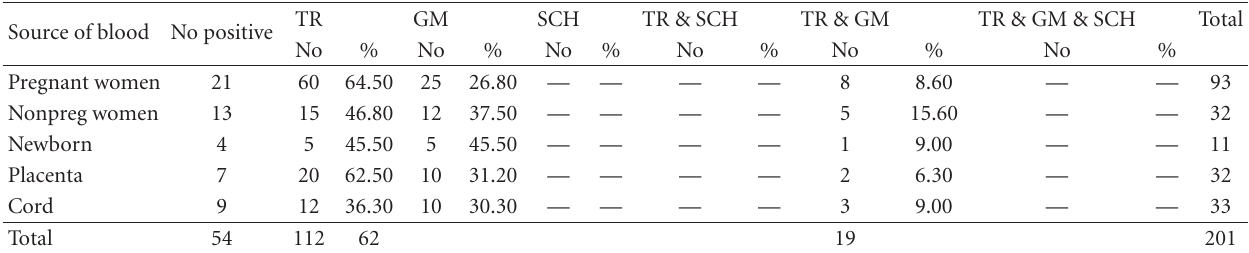
Table 3: Erythrocytic stages of Plasmodium falciparum in blood samples of di ff erent groups of women and tissues at General Hospital Minna, North central Nigeria. Source of blood No positive